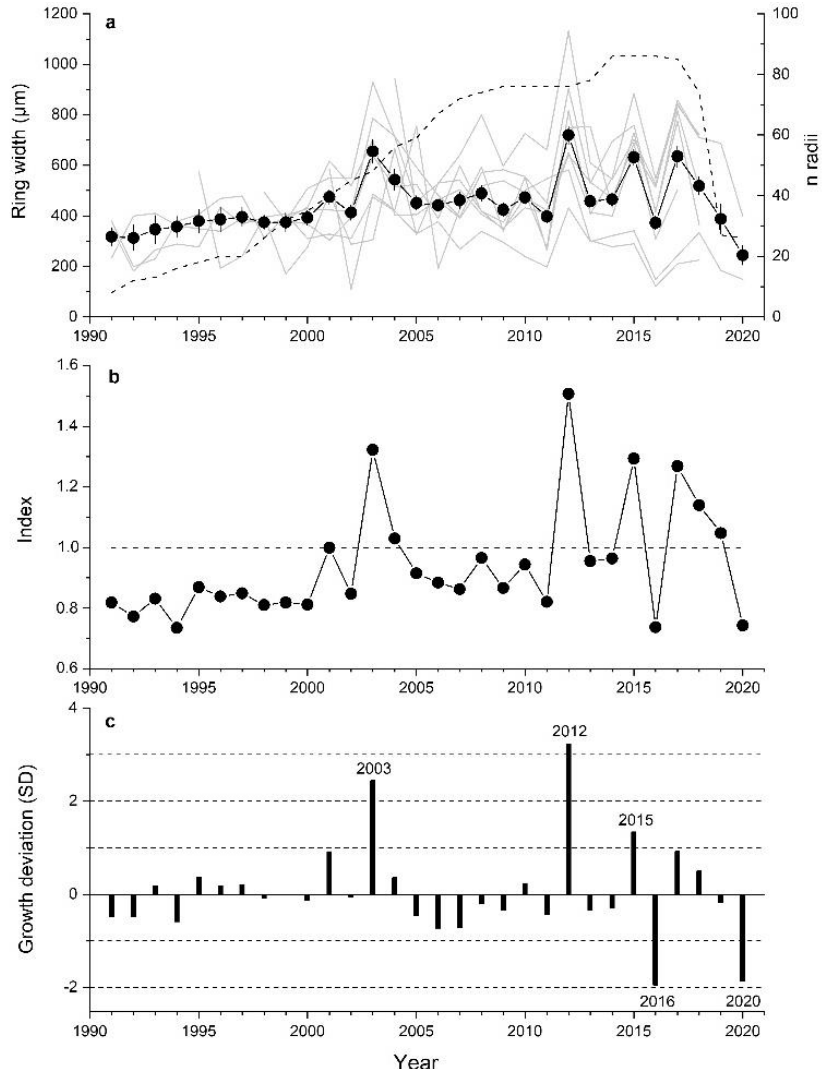
Figure 2. ( a ) Composite ring width time series ( ± standard error; closed symbols and bold line) and site chronologies (grey lines) of Alnus alnobetula stems from 8 study plots (see Table 1). Number of stems included in the composite chronology ( n > 5) is shown as dashed line. ( b ) Standardized chronology used as predictand in response function analysis. ( c ) Current year growth in relation to average value of previous 5 years given in standard deviation units (SD). Extreme growth years showing deviation > ± 1 SD are indicated (for details see Materials and